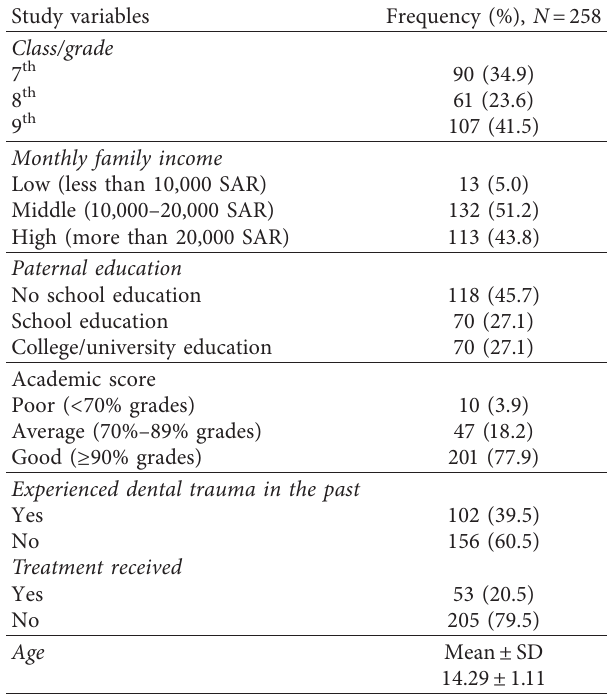
Table 1: Demographic profile of study participants. Study